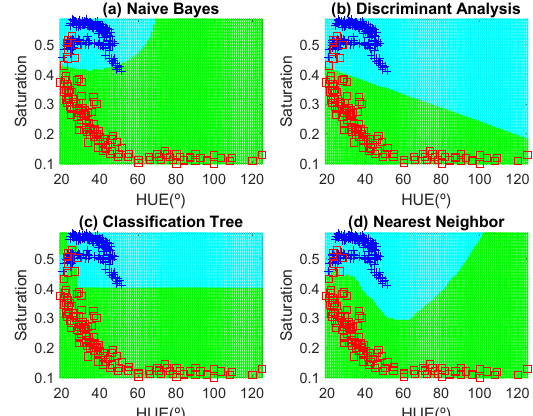
Sensors 2019 , 19 , x Figure 12. Decision boundaries and scatter plot (class 1 squares, class 2, crosses) for the golden apple. ( a ) Naive Bayes, ( b ) linear discriminant analysis, ( c ) classification tree and ( d ) Nearest Neighbor (k = 5).